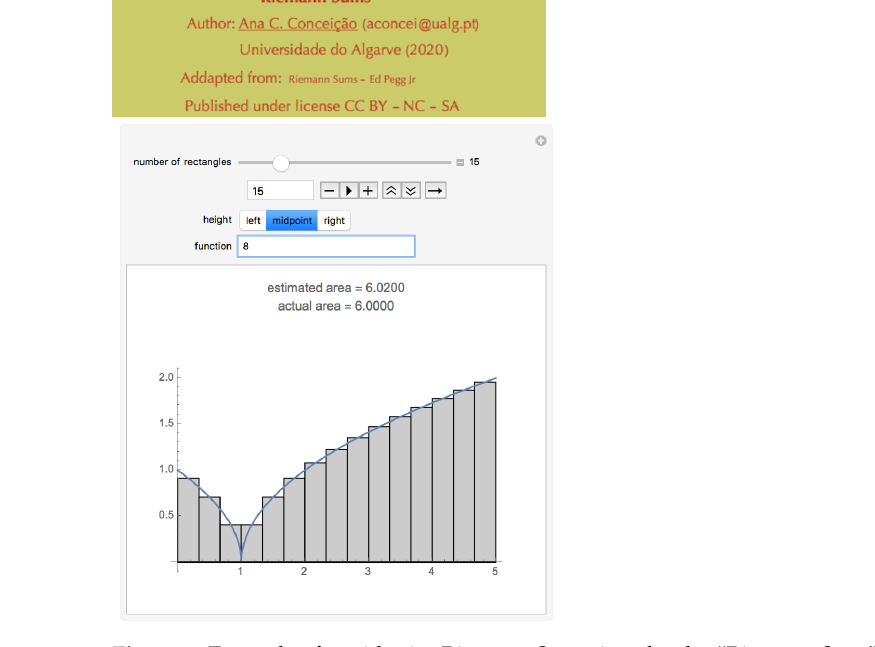
Figure 7. Example of a midpoint Riemann Sum given by the “Riemann Sum” active leaning